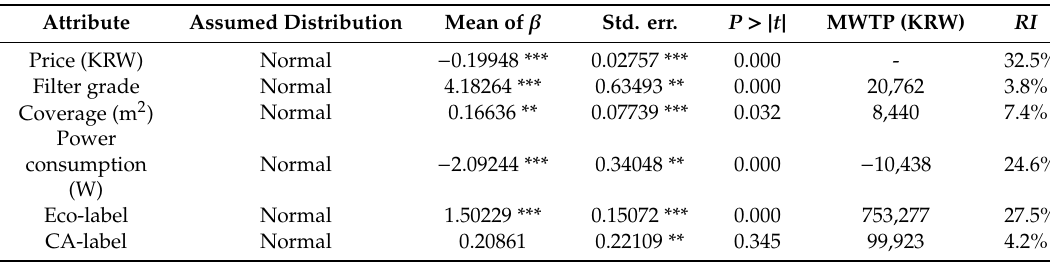
Table 4. Estimation result of mixed logit